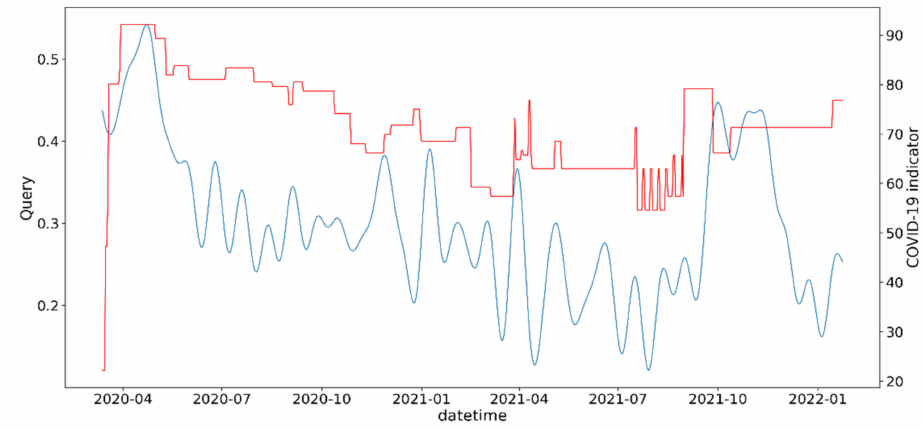
Figure A9. COVID-19—Stringency index. Query—crisis lending debt